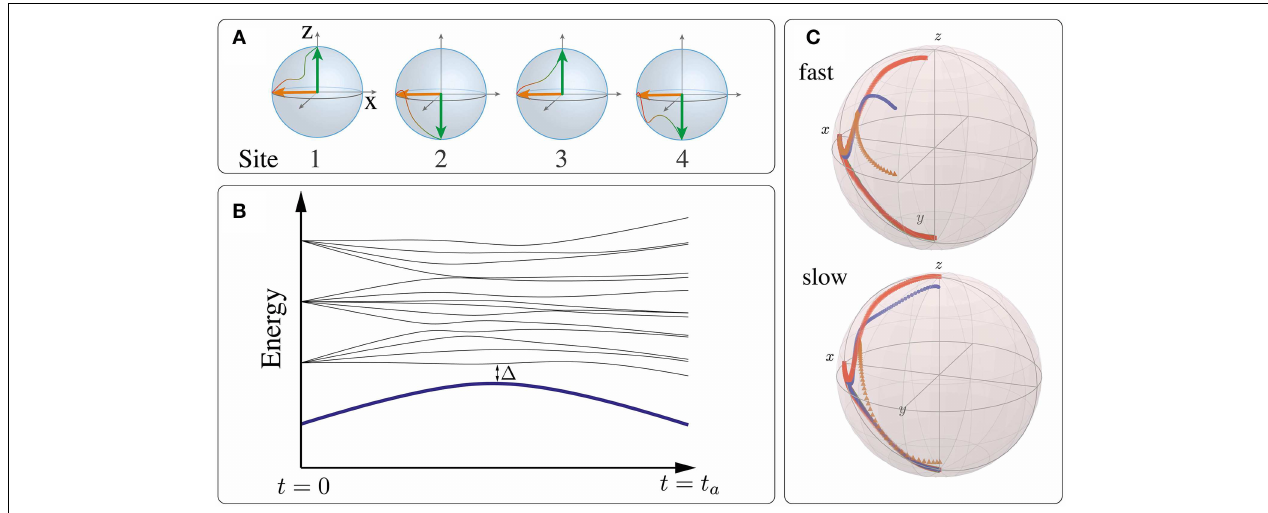
shielded from decoherence effects, the system remains in the instantaneous ground state (thick blue) protected by the gap 1 . (C) Evolution of the state vectors of four spins (indicated by different colors) on the Bloch sphere for a typical choice of interactions J ij . For slow annealing ( t a 512 / J , bottom), the = protocol does reach the final ground state at the poles of the Bloch sphere, while it fails to do so for fast annealing ( t a 64 / J , =